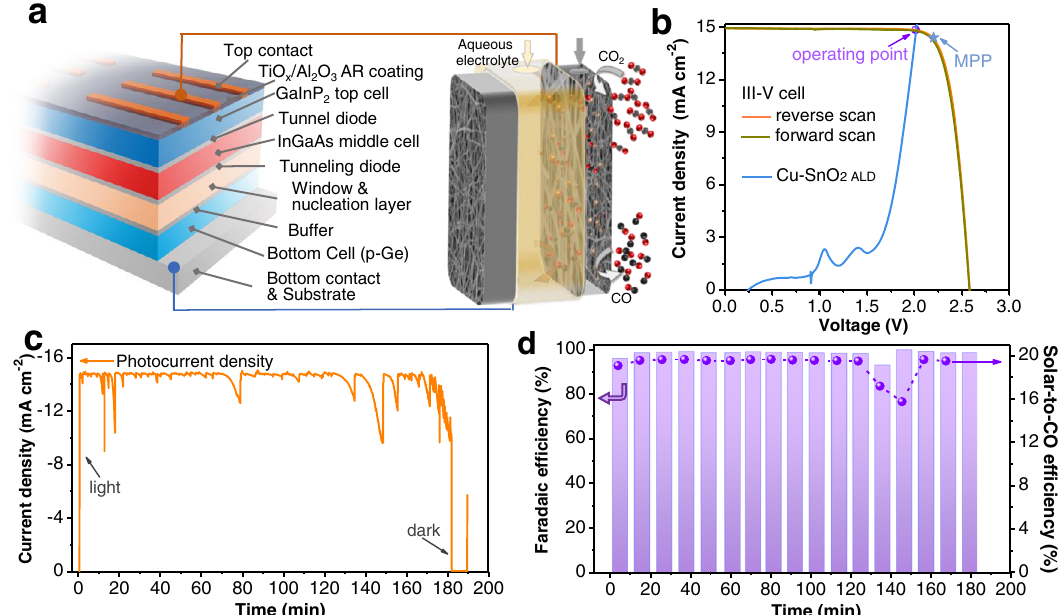
Fig. 5 | Photosynthesis ofCO from solar-drivenCO 2 reduction. a A schematic of the solar driven system which consists of a III-V triple junction solarcell and a fl ow reactor. b Representative linear sweep voltammograms of the solar cell and elec- trolysiscell. c PhotocurrentdensityoftheunassistedPV-ECsystemunderstandard AM1.5Gillumination. d Faradaicef fi ciencyofgeneratedCOandcalculatedsolar-to-